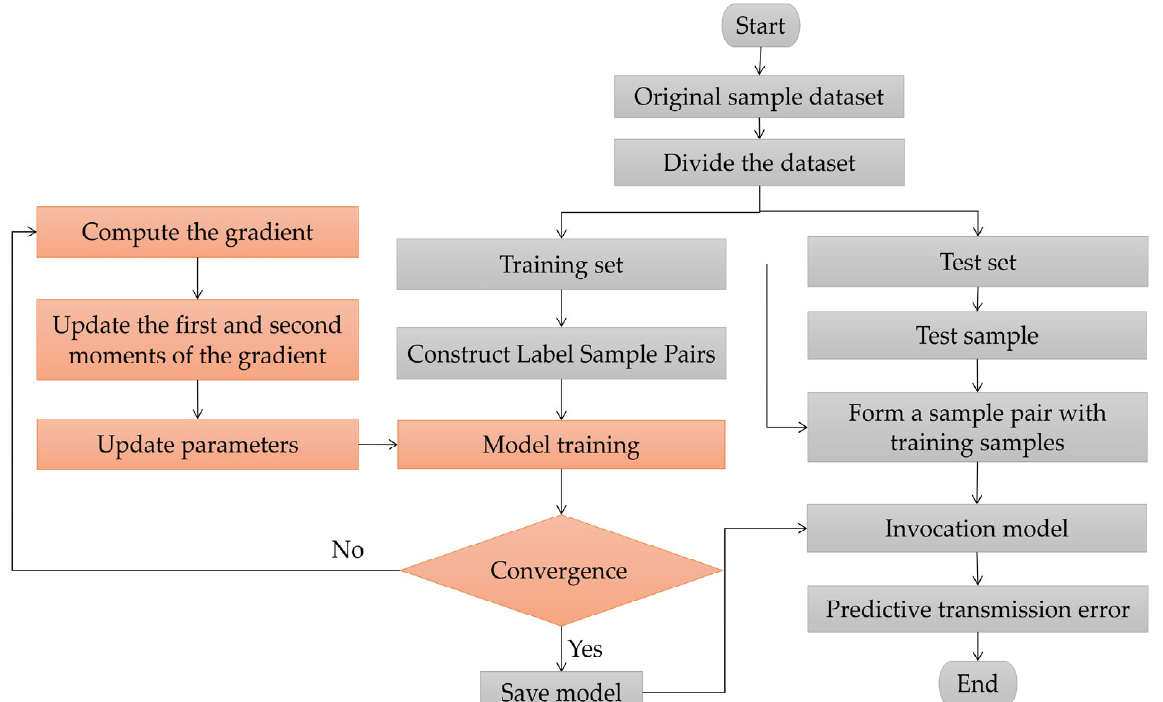
Figure 5. Prediction flow chart of the DDNN model.